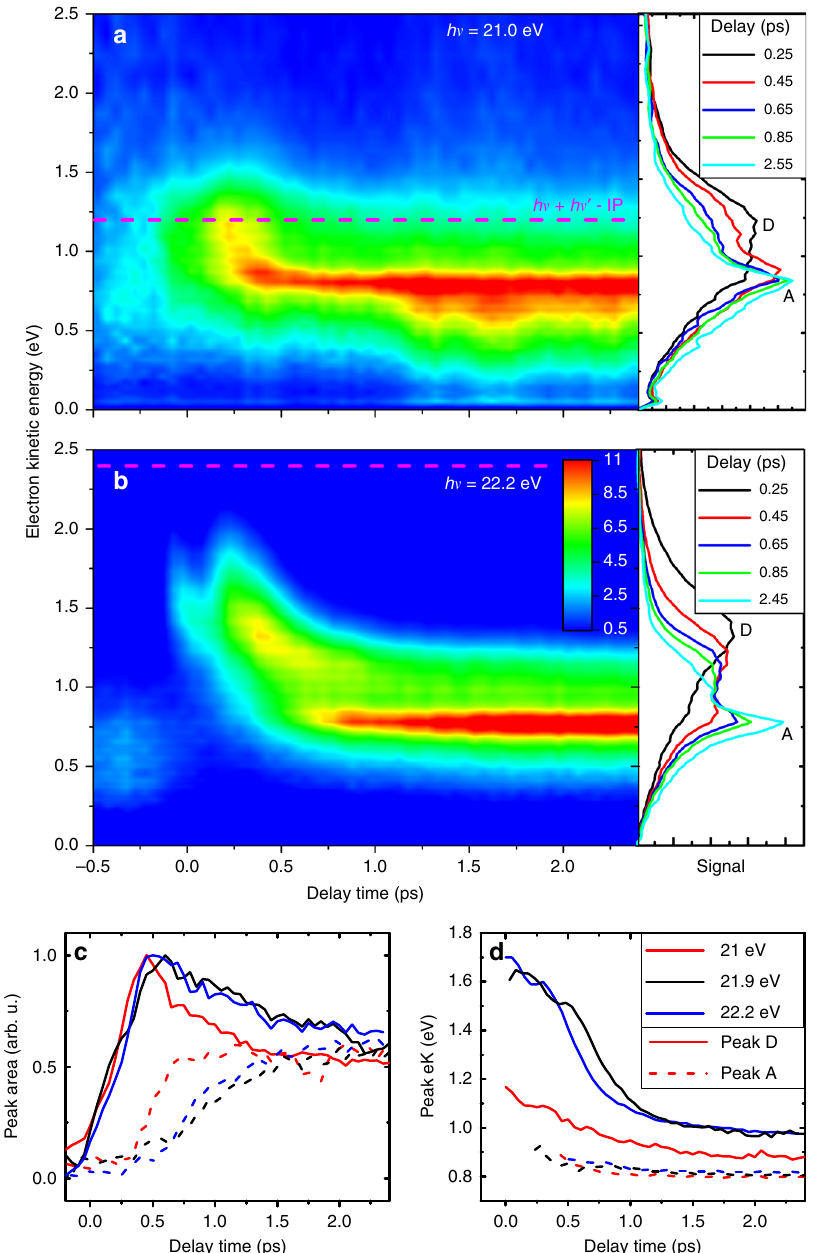
Fig. 2 Time-resolved photoelectron spectra. The He nanodroplets contained on average N ¼ 5 ´ 10 5 He atoms and were excited to their 1s2s state at the pump photon energy h ν ¼ 21 : 0 eV ( a ) and their 1s2p state at h ν ¼ 22 : 2 eV ( b ). The probe photon energy is h ν 0 ¼ 4 : 8 eV. The horizontal dashed lines indicate the electron energy corresponding to direct two-photon ionization of He. The panels on the right-hand sides show the electron spectra recorded at various fi xed pump-probe delays. The bottom panels show the results of fi tting the spectra with multiple peaks (area in ( c ), position in ( d